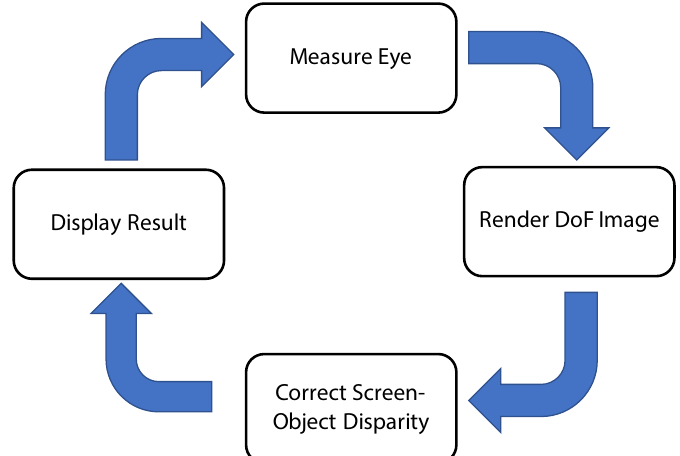
Figure 3. EyeAR is a closed-loop system: Given eye measurements, we generate a realistic DoF image. After correcting the offset between the screen and the virtual object, we present the results on the screen, which triggers a response by the user’s